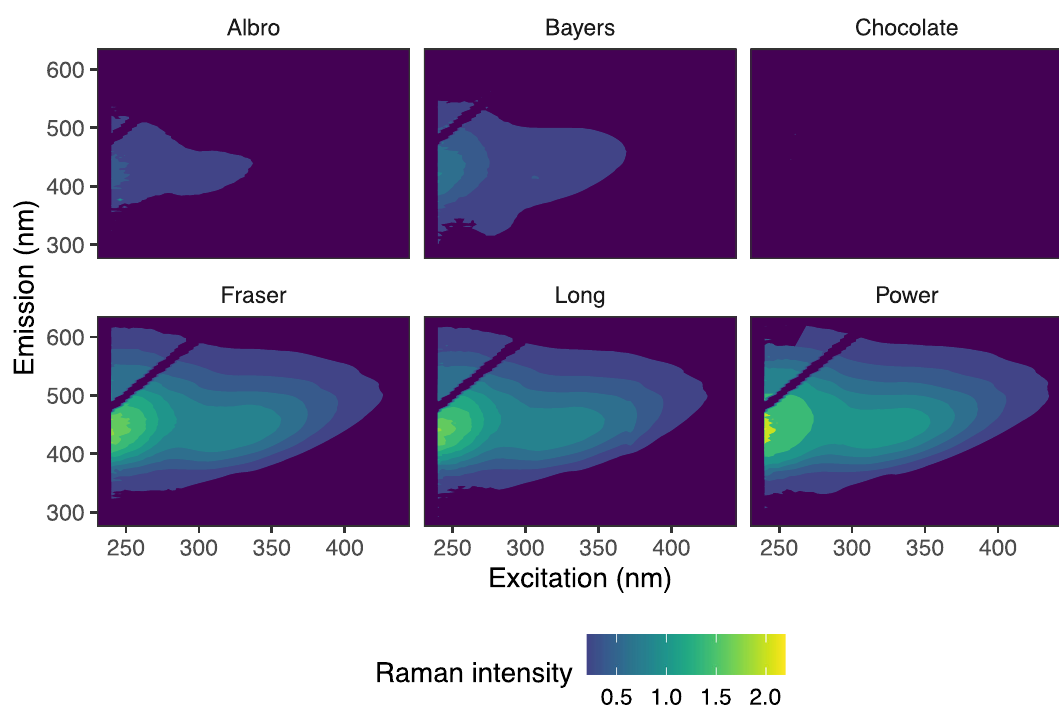
Fig. 1 Fluorescence excitation-emission matrices (EEMs) representing the six lakes in the dataset. The Raman intensity at each excitation- emission coordinate represents an average of multiple EEMs. Data were collected in 2019 (Table